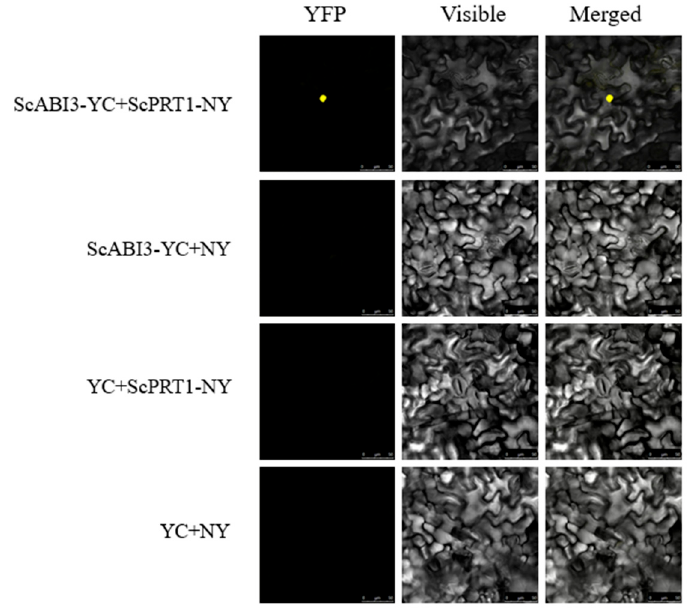
Figure 5. BiFC assay shows that ScABI3 interacts with ScPRT1 in N. benthamiana leaf epidermal cells. ScABI3 was fused to the C-terminal fragment of YFP (YC) and ScPRT1 was fused to the N-terminal fragment of YFP (NY). The interaction between ScABI3-YC and NY or YC and ScPRT1-NY or YC and NY serves as the negative controls.